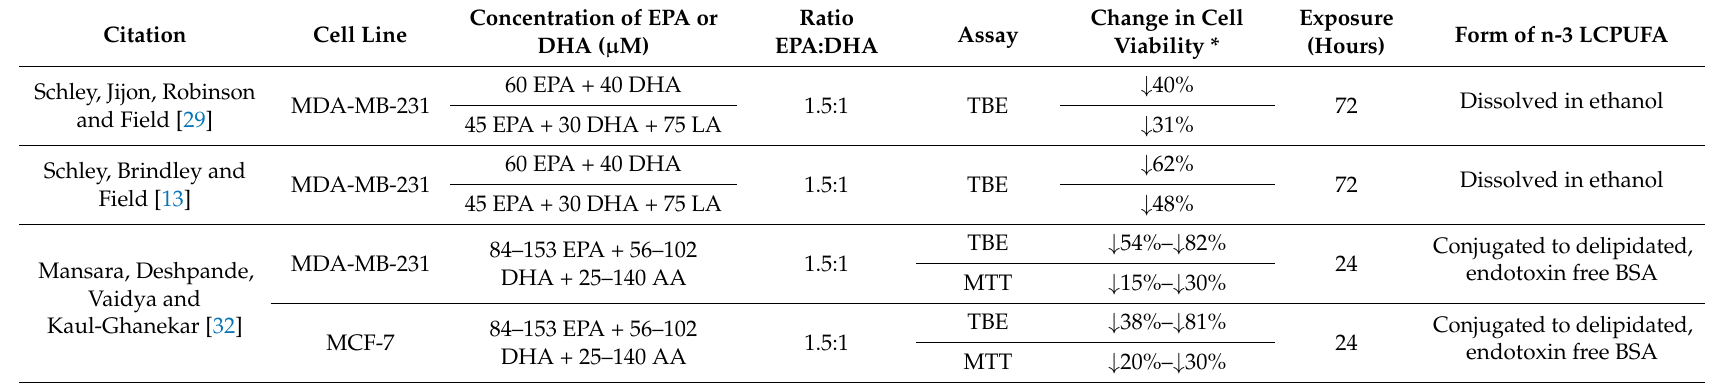
Table 5. Comparison of EPA:DHA mixtures on cell viability in human BC cell